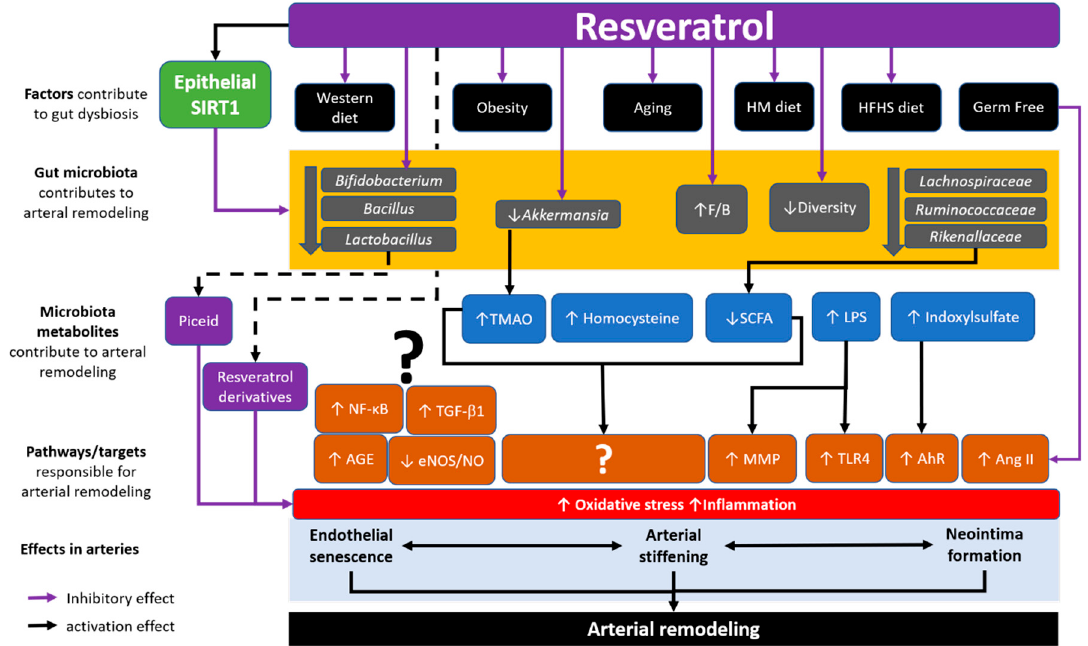
Figure 2. Gut microbiota is a critical player in the effect of resveratrol in arterial remodelling. Environments factors such as diets can affect the population of the gut microbiota. Inappropriate diet such as high fat diet (HFD), as well as aging and obesity, can cause gut dysbiosis. Gut dysbiosis includes the reduction of species diversity, increased F/B ratio and the reduction of good microbes (e.g., Baillus, Lactobacillus , Ruminococcaceae , Akkermansia , etc.) can cause arterial remodelling and other cardiovascular complications. Interestingly, germ-free mice show reduced Ang II activation compared to conventional mice. Resveratrol has been shown to normalize the gut dysbiosis in certain diet models, increase the microbial diversity and good bacteria and reduce the F/B ratio. Resveratrol isoforms and derivatives are modulated by the gut microbiota and have more potent effect in antioxidant and anti-inflammation. Gut dysbiosis also results in the changes in microbiota derived metabolites, including the increase in TMAO, homocysteine, LPS and indoxylsulfate, and the reduction of SCFA (e.g., butyrate). Further studies directions may address the potential pathways and/or targets that are modulated by the microbiota derived metabolites in responsible for arterial remodelling. Also, the association between the known pathways that induce arterial remodelling and gut microbiota and metabolites should be dissected. HM diet: high methionine diet. HFHS diet: high fat high salt diet. F/B: Firmicutes to Bacteroidetes ratio. TMAO, Trimethylamine- N -oxide. LPS, lipopolysaccharide. SCFA, short-chain fatty acids. NF- κ B, nuclear factor kappa-light-chain-enhancer of activated B cells. TGF- β 1, transforming growth factor-beta 1. AGE, Advanced glycation end-product. eNOS, endothelial nitric oxide synthase. NO, nitric oxide. MMP, matrix metalloproteinases. TLR4, toll-like receptor 4. AhR, aryl hydrocarbon receptor. Ang II, angiotensin II.